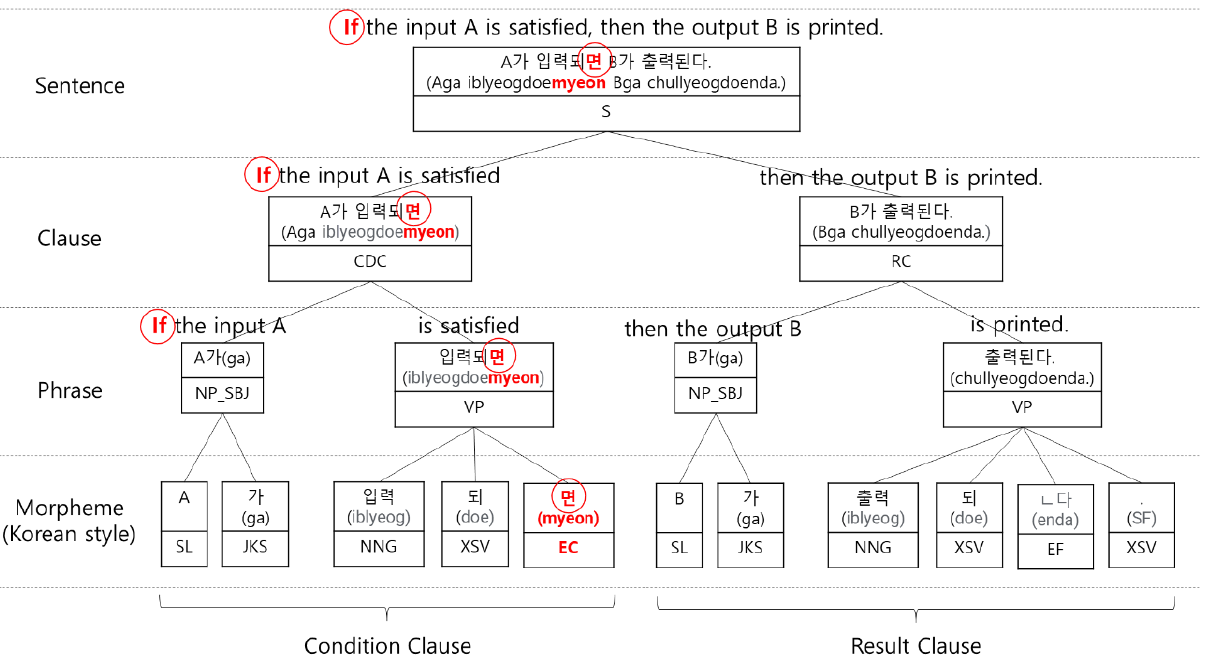
Figure 4. Identification of conditional clauses.